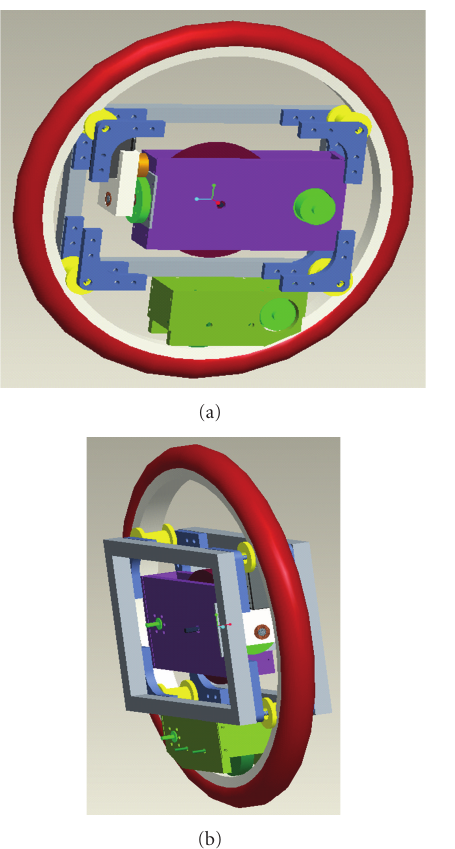
Figure 10: Design of GYROBO II.